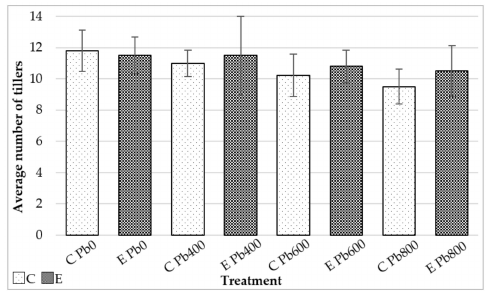
Figure 6. Average of total tillers per pot produced by Festuca arundinacea with endophyte treatment ( E ) were compared with control treatment ( C ) at increasing concentration of lead in the soil. Bars in the graph represent the standard